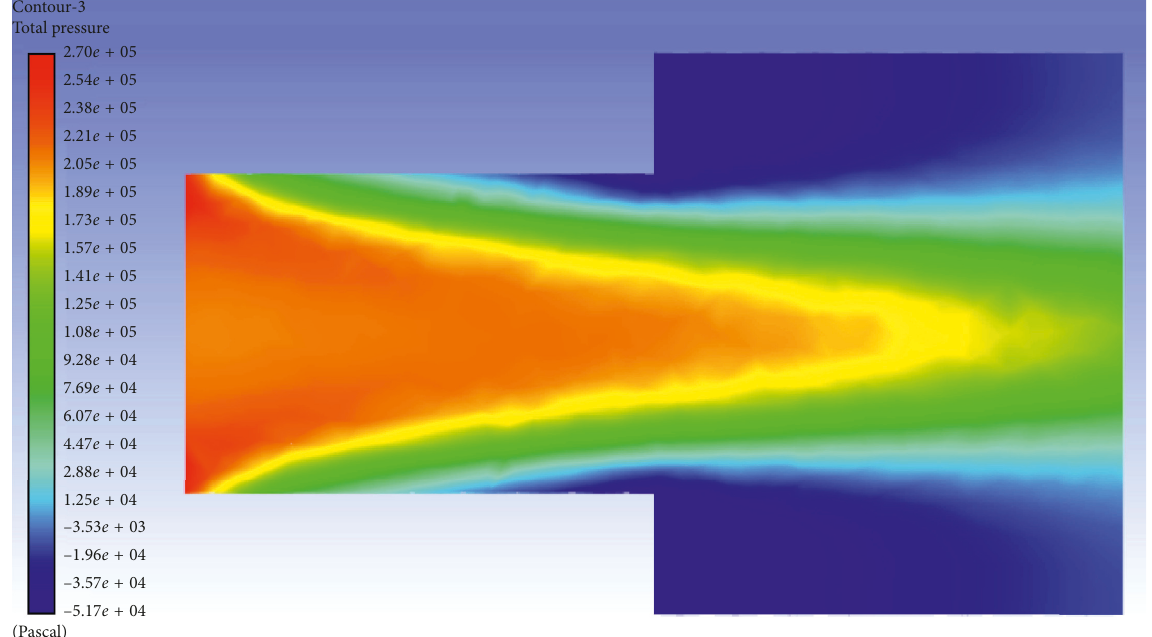
Figure 14: Pressure nephogram (sudden expansion ratio is